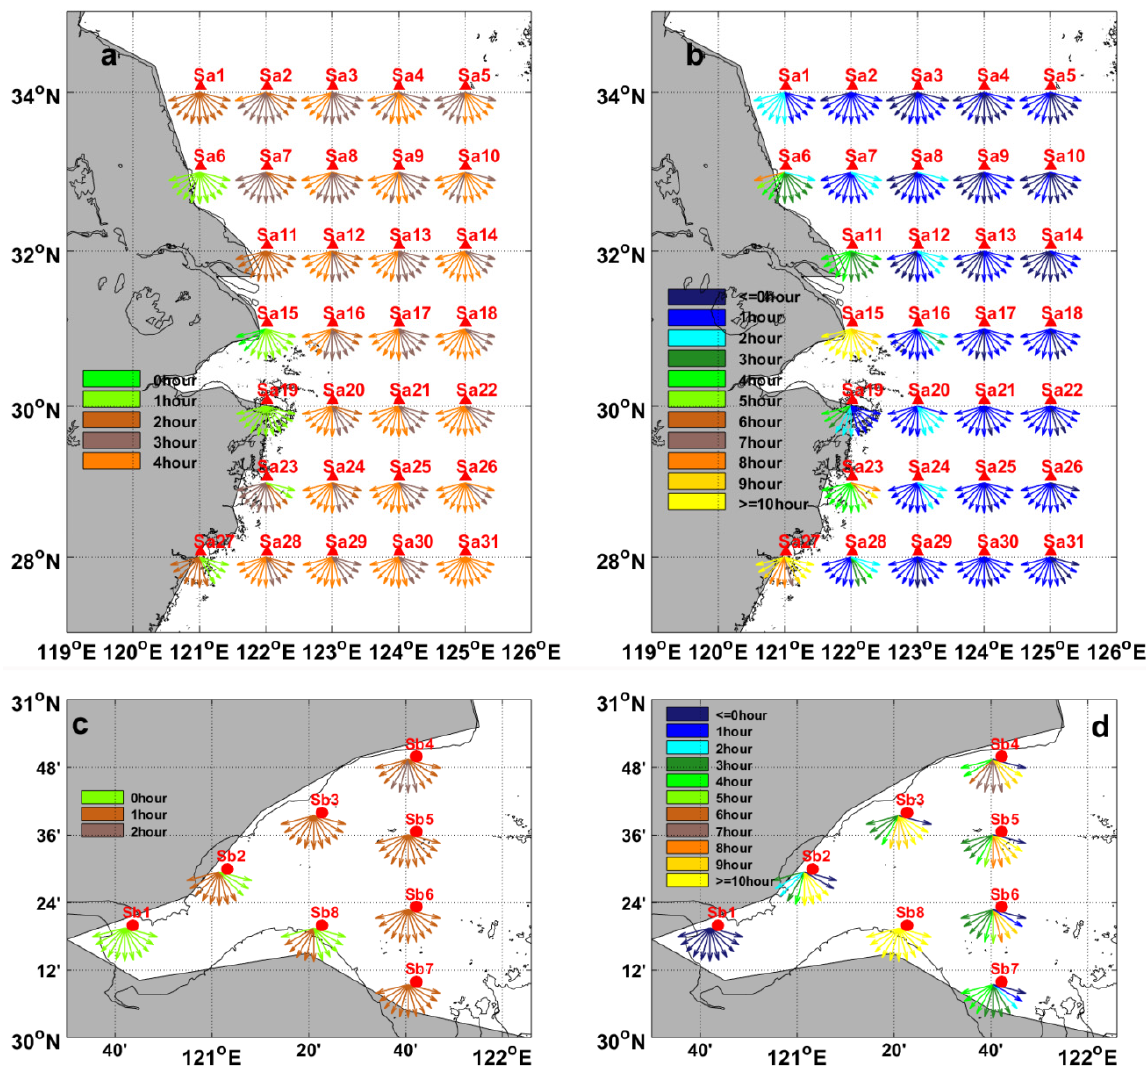
Figure 11. ( a ) The time difference between the occurrence of MSWH and the occurrence of maximum wind speed (MWS) at Sa stations in eleven numerical experiments; ( b ) same, for the time difference between the occurrence of MSH and the occurrence of MWS; ( c ) same, for the Sb stations; ( d ) Same, for the Sb